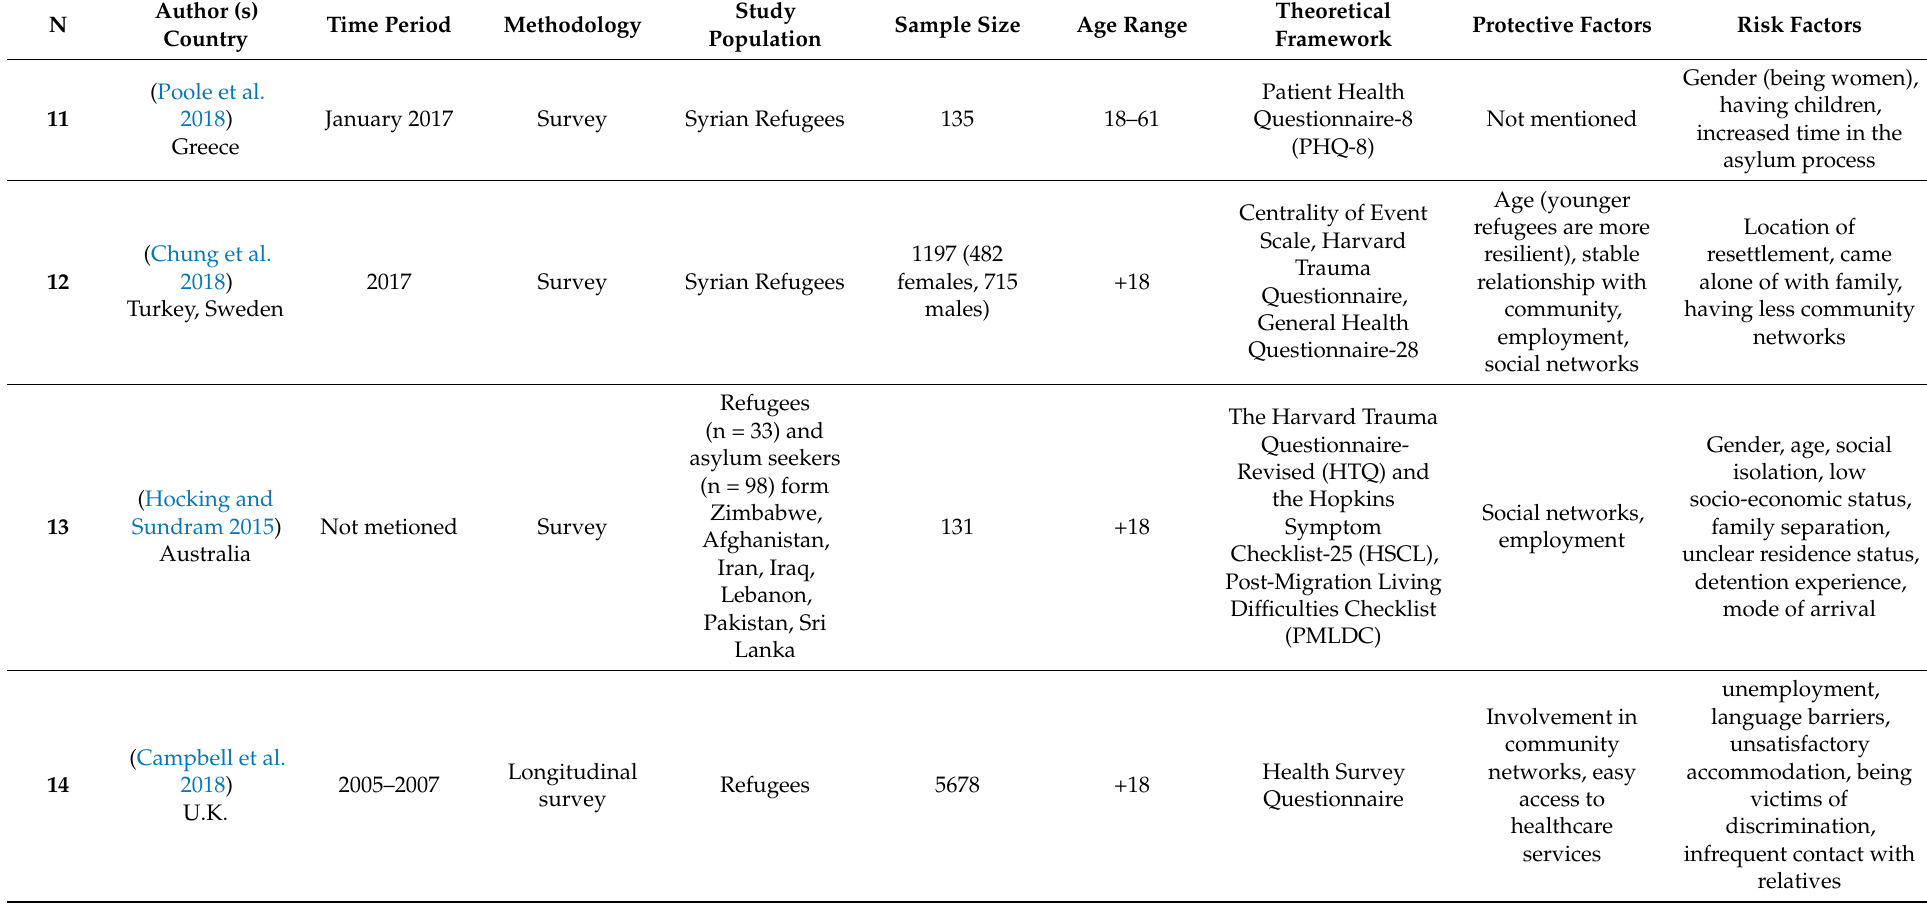
Table 2. Characteristics of the included quantitative